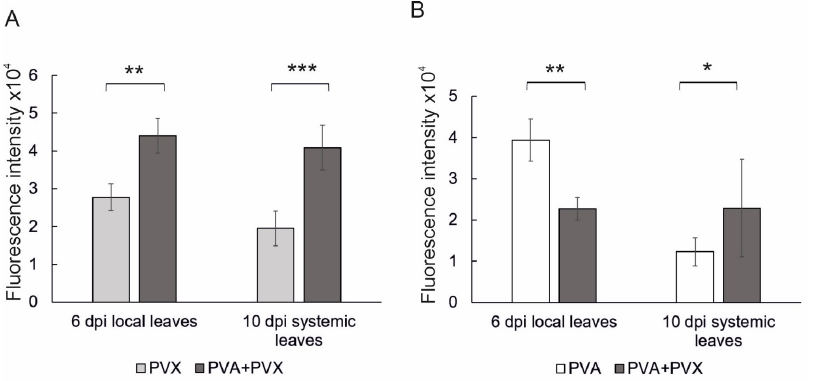
Figure 1. Quantification of reporter gene expression in single and mixed PVA and PVX infections revealed synergistic benefits for PVX in both local and systemic leaves. ( A ) PVX-derived GFP and ( B ) PVA-derived RFP fluorescence intensities were measured from local and systemic samples at 6 and 10 dpi, respectively. Averages of one independent experiment ( n = 8–9 plants per treatment) are shown. Error bars indicate standard deviation and statistical significance was calculated with Student’s t -test (* p < 0.05, ** p < 0.01, *** p < 0.001).